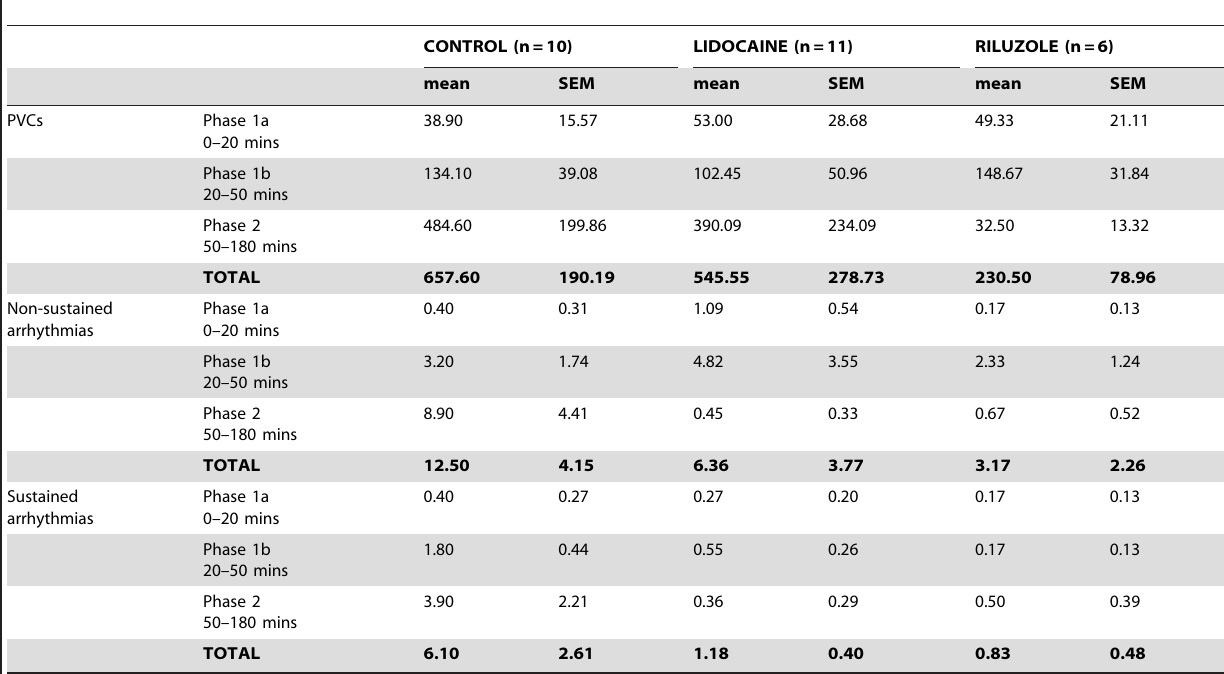
Table 1. Average number of arrhythmias per animal for each group in each of the phases. ‘‘n’’ refers to the number of animals in each group.